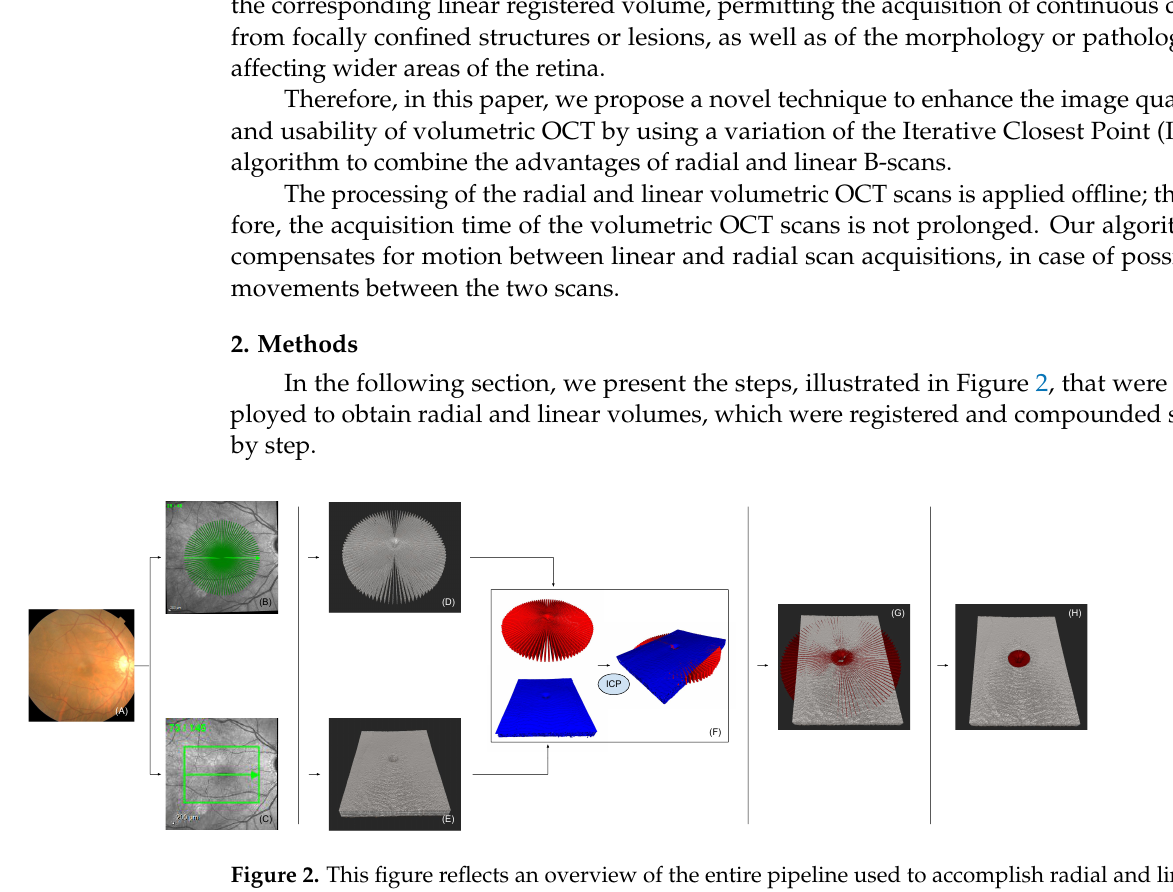
Figure 2. This figure reflects an overview of the entire pipeline used to accomplish radial and linear volumetric OCT registration and fusion. ( A ) shows the fundus image of the retina. Image ( B , C ) show the chosen scan area with the correlating scan pattern (( A ) radial scan pattern; ( B ) linear scan pattern). The acquisition was subsequently performed, but post-processing was conducted simultaneously. Images ( B , D ) represent the 3D-OCT volumes that correspond to ( B , C ). ( F ) shows the point clouds generated from ( D , E ) and registered via ICP. Image ( G ) shows the radial volumetric OCT (red) fused with the linear volumetric OCT (gray). ( H ) presents the final result, with the advantageous chosen radial volumetric OCT area in red, surrounded by the linear volumetric